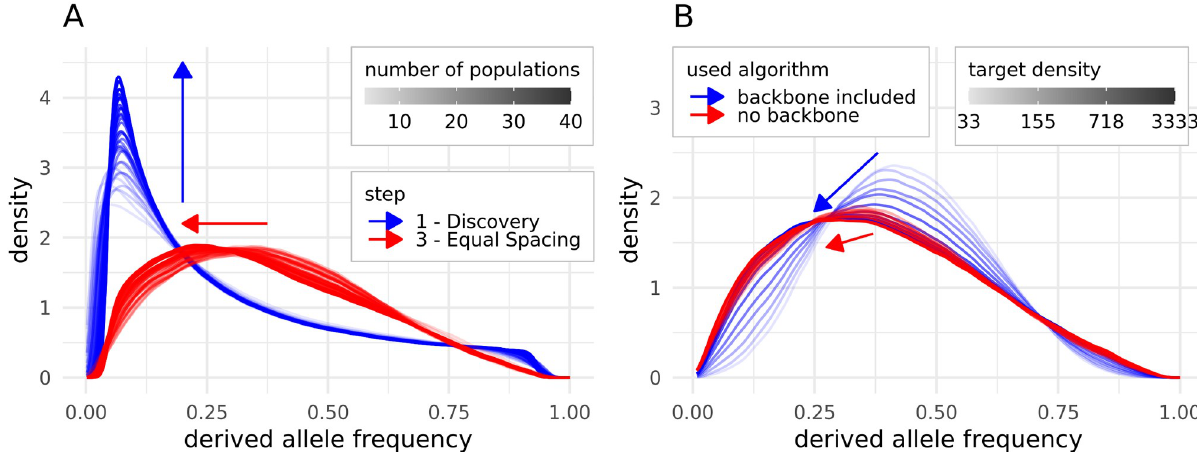
Fig 4. Impact of a varying number of discovery populations (A) or target density (B) on the derived allele frequency spectrum. For A, blue indicates the spectra after the discovery step and red after the equal spacing step. For B, only the equal spacing step is shown and blue indicates that the algorithm including the initial backbone, while red shows the results without the backbone included in the algorithm. Different numbers of populations in the discovery set (4 to 40) or the increase in the target density are indicated by an intensifying color gradient and only one representative and randomly picked run per population number/ target density is shown. As the differences in the color gradients are hard to distinguish, arrows in the respective color are indicating the shift of the spectra with increasing numbers of discovery populations.